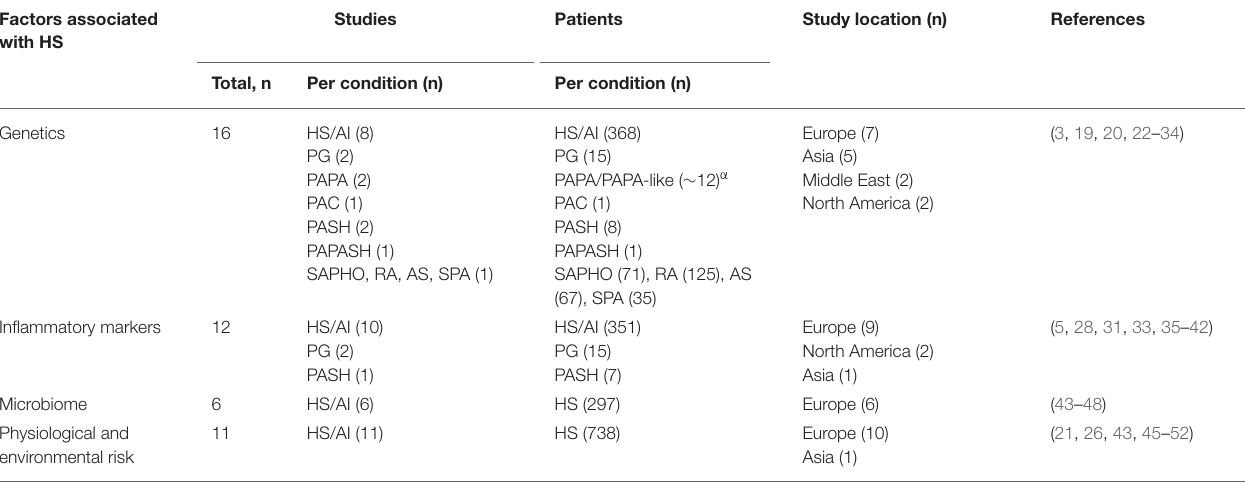
TABLE 1 | Characteristics of included